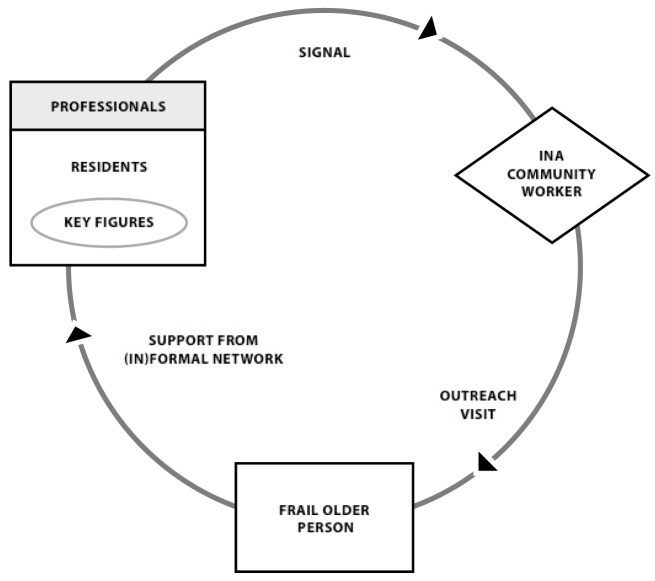
Working method INA.